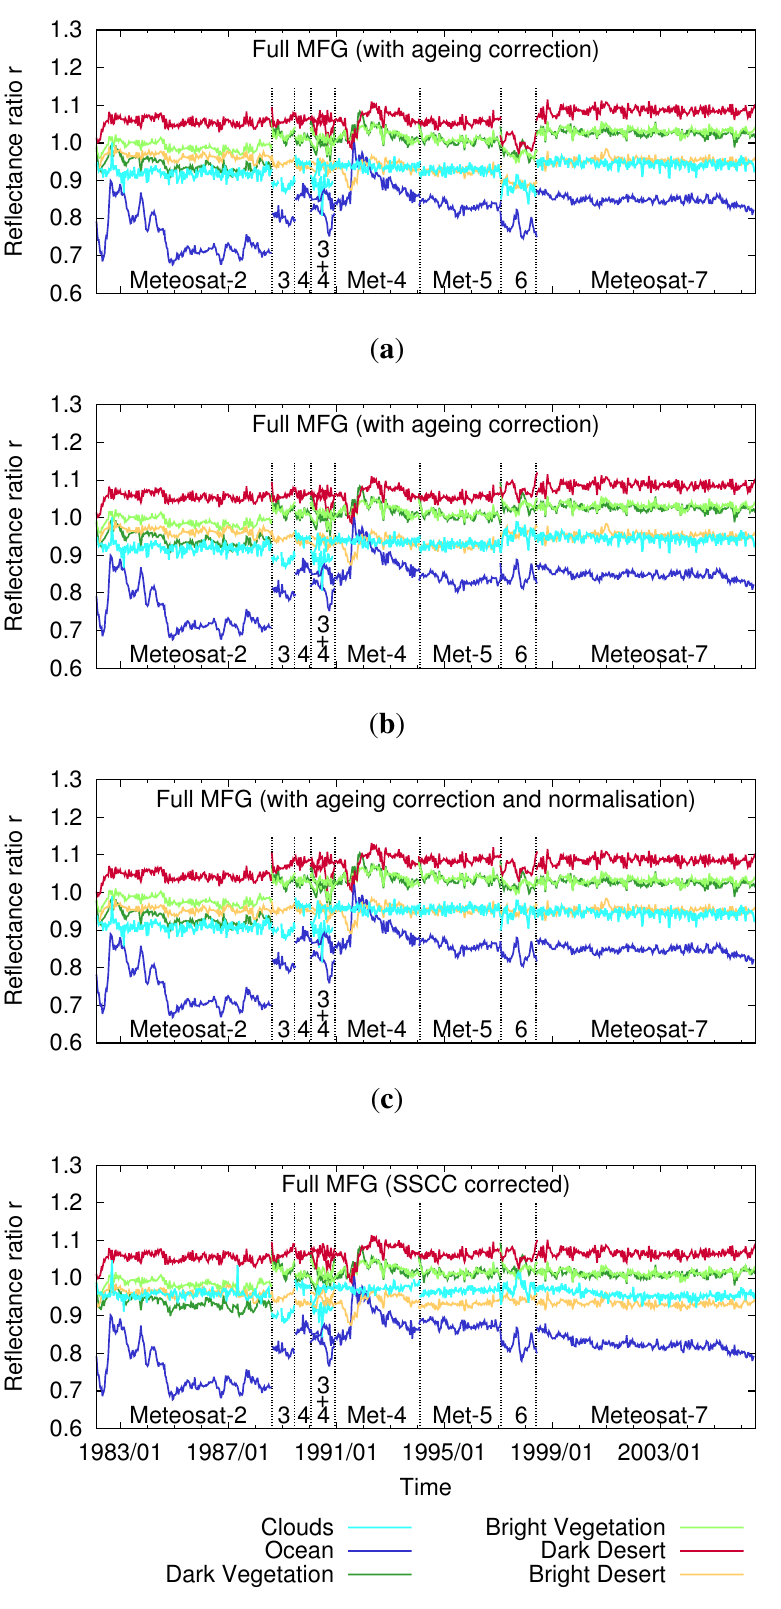
Figure 19. The ageing corrected time series with ( a ) the time series corrected using the minimisation technique for each satellite individually; ( b ) the same time series, where the parameters of Meteosat-6 have been manually corrected; ( c ) the normalised time series and ( d ) the time series corrected using the SSCC